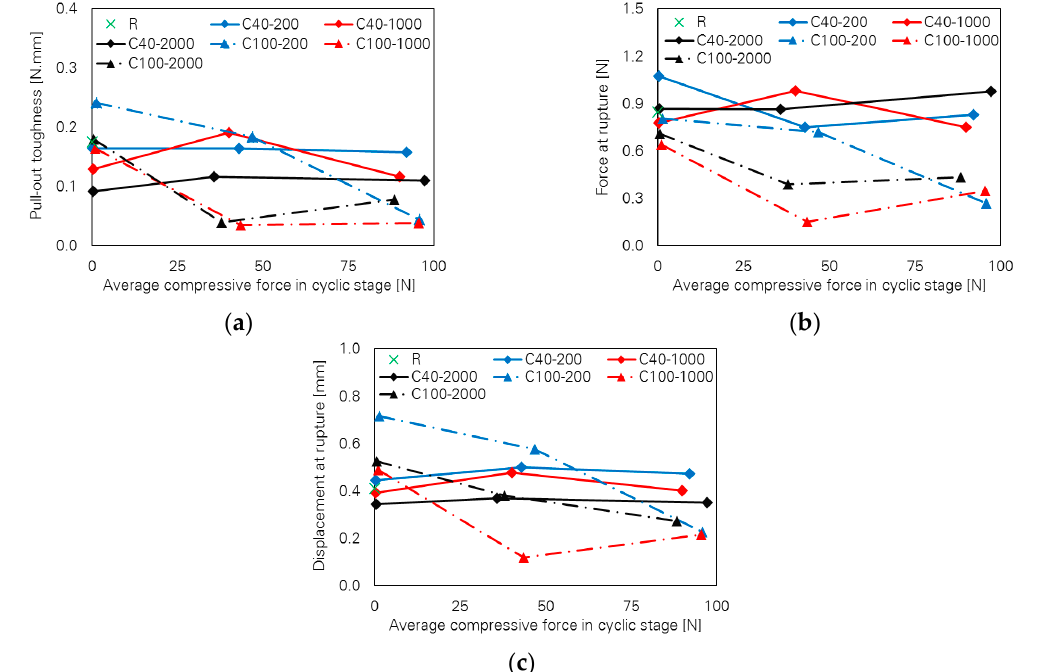
Figure 10. Combined influence of crack width and loading parameters on the crack-bridging capacity of PVA fibres: ( a ) pull-out toughness, ( b ) force and ( c ) displacement at fibre rupture.